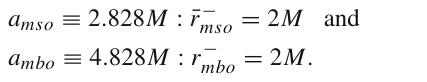
Fig. 12 Test particle orbits with trajectories inversion points in the NS geometry with spin a = 1 . 1 M . The (counter-rotating) particle flows specific angular momentum is (cid:6) = − 4 . 8. There are two orbit- ing counter-rotating tori. In Fig. 11 there is the analysis for the photons trajectories and description of the toroidal models. The initial radius is r 0 < r × , where r × is the torus inner edge. The inversion sphere r (cid:2) is